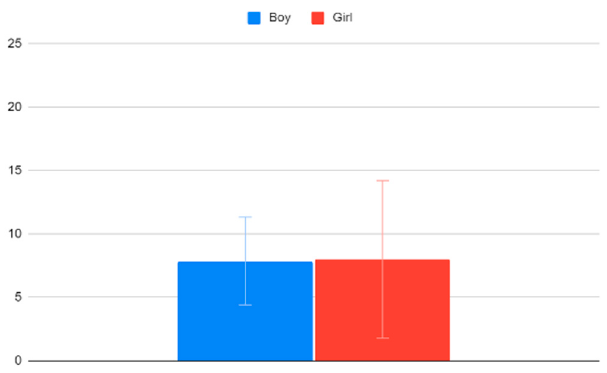
Figure 6. VACS values for boys and girls.